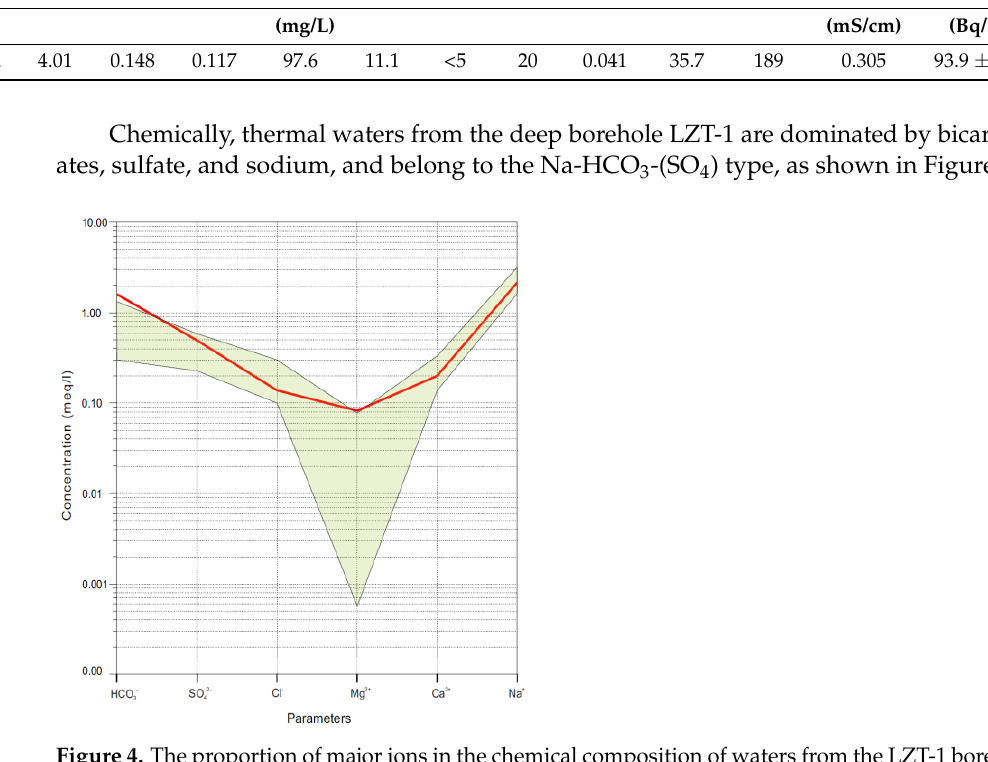
Figure 5. Chemical composition of the Lądek-Zdrój thermal waters on a Piper diagram (based on [79] updated). This water type suggests that dissolution of silicate might be the source of Na 2+ . The silicate and carbonate rocks dissolution might be responsible for bicarbonates concentra- tion. 3.2. Estimation of Reservoir Temperature